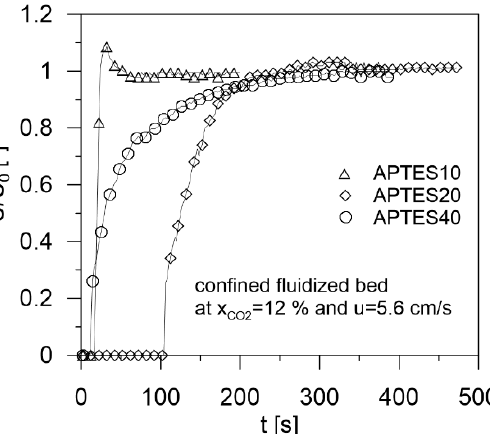
Figure 8. Breakthrough curves at a fixed concentration of CO 2 (12%) for functionalized silica.